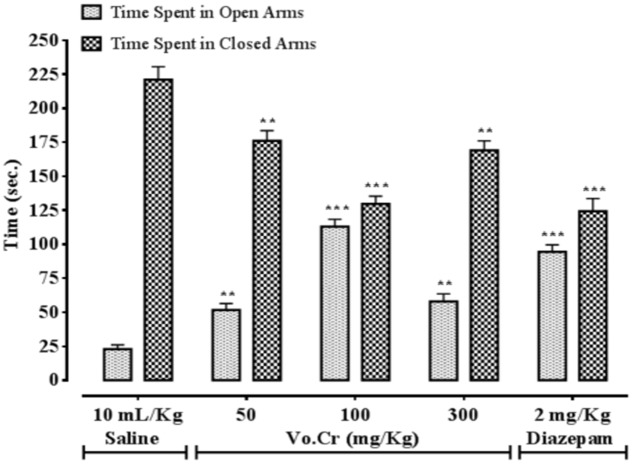
Bar-graph showing effects of Verbena officinalis crude extract (Vo.Cr) and diazepam on time spent by mice in open and closed arms in elevated plus maze model. Data expressed as mean ± SEM, n = 4. ∗∗P < 0.01, ∗∗∗P < 0.001 vs. saline group, one-way ANOVA with post hoc Tukey test.